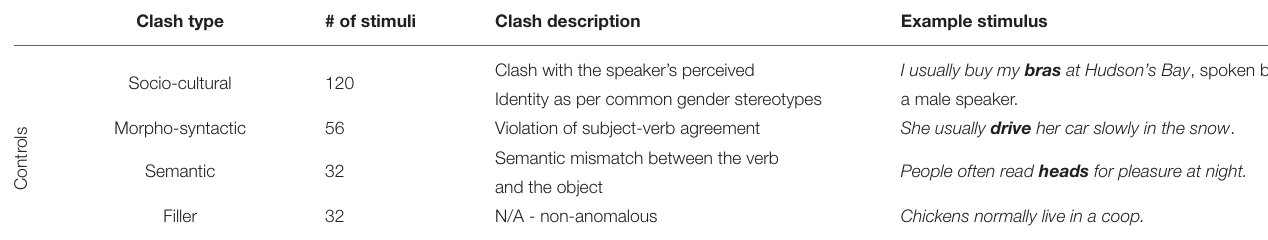
TABLE 1 | Overview of stimuli and experimental